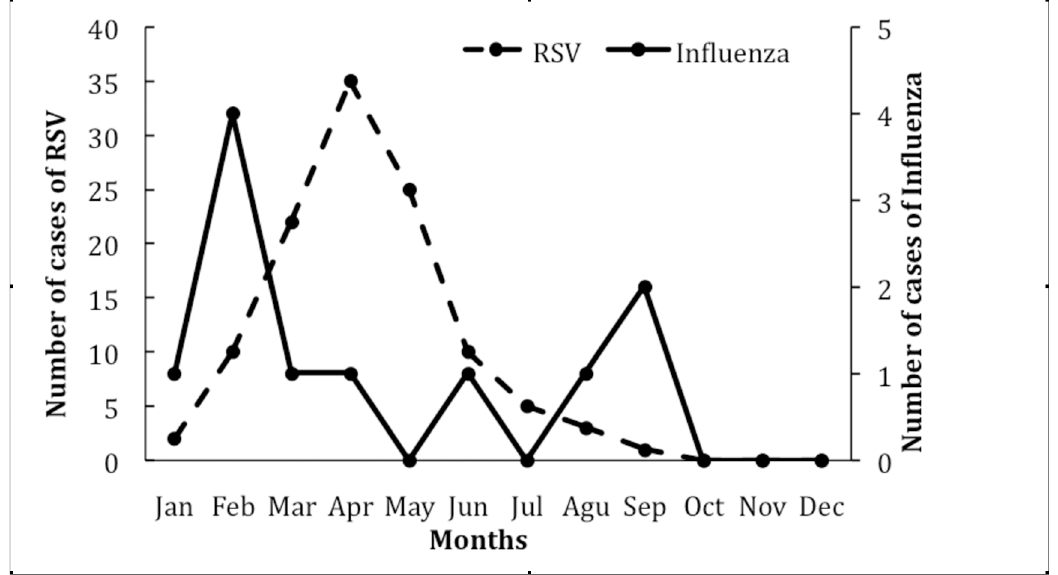
Fig 2. Monthly and seasonal variation of cases of influenza and RSV. The graph depicts the monthly and seasonal variationof cases of influenza(right axis) and RSV (left axis).